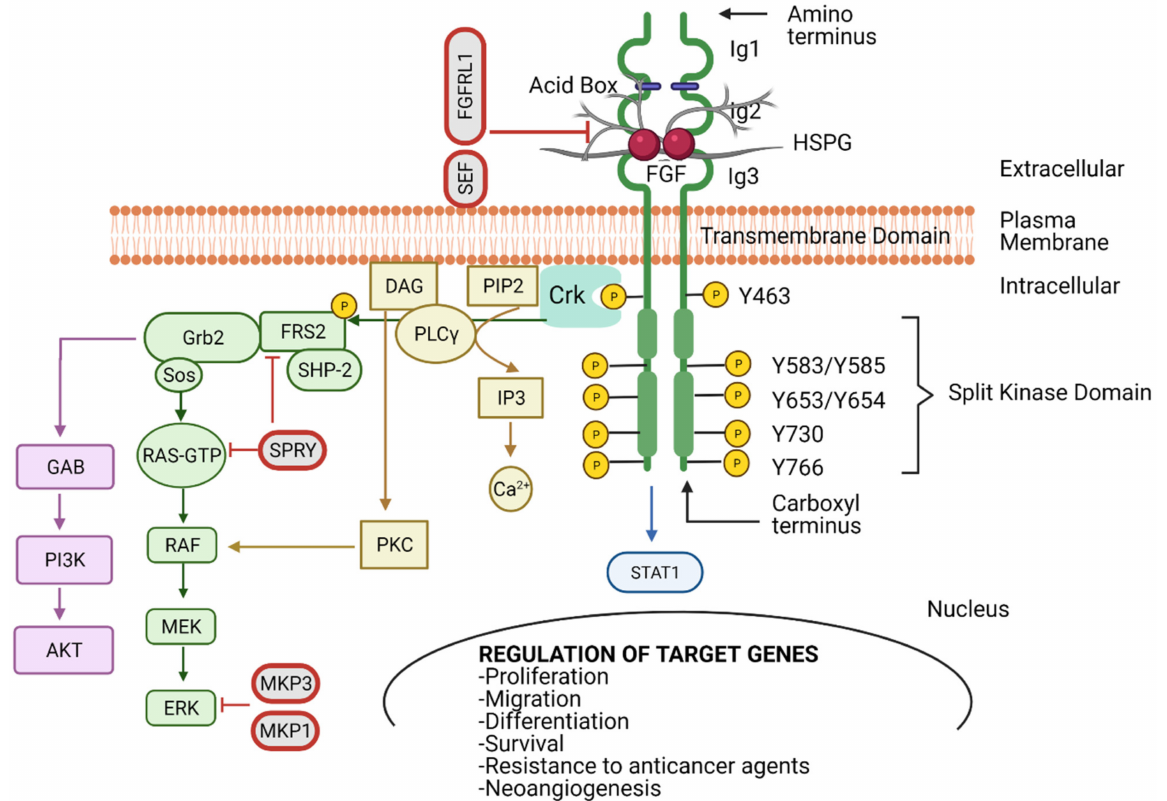
Figure 1. Fibroblast growth factor receptor (FGFR) structure and function. FGFR possesses three immunoglobulin-like domains (Ig1–3), an acid box (AB), a transmembrane domain (TM), and an intracellular tyrosine kinase domain that is split into two (TK1 and TK2). The FGF–FGFR complex is composed by two FGFs, two FGFRs and one heparin sulphate proteoglycan (HSPG). The TK domains are transphosphorylated upon ligand binding between Ig2-Ig3 and receptor dimerisation. This initiates the interaction between a network of downstream signalling molecules that can activate key pathways, such as MAPK, AKT, PLC γ , STAT1 and in turn regulate target genes involved in cell proliferation, migration, differentiation, survival, resistance to anticancer agents and neoangiogenesis. Signalling can be negatively regulated by SEF, FGFR-like 1 (FGFRL1), sprouty (SPRY) and MAPK phosphatase 1 and 3 (MKP1 and MKP3) at different levels. Created with BioRender.com (accessed on 26 September